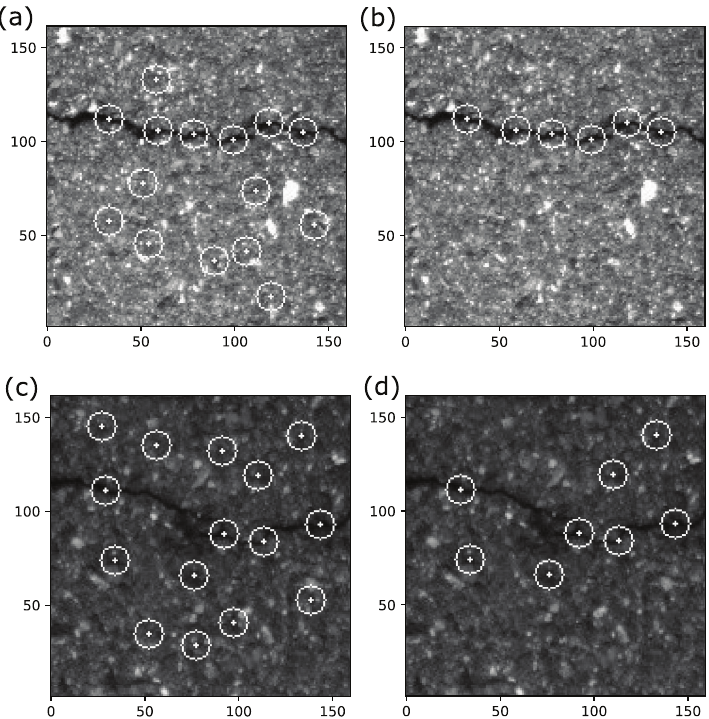
Figure 2. ( a , c ) Two typical pavement image windows of different brightness and cracks, and the local extremum points. ( b , d ) The feature points picked up from the local extremum points.